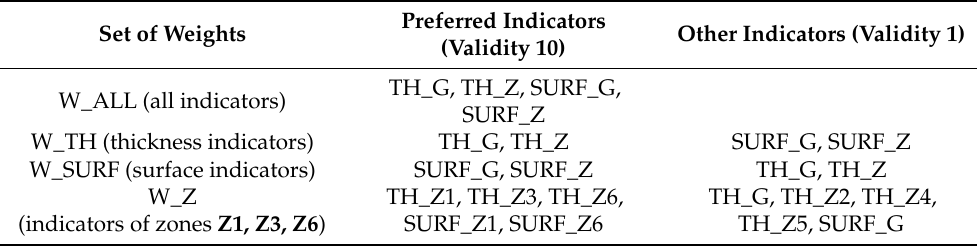
Table 7. The weight sets used to optimise shear forming parameters. Set of